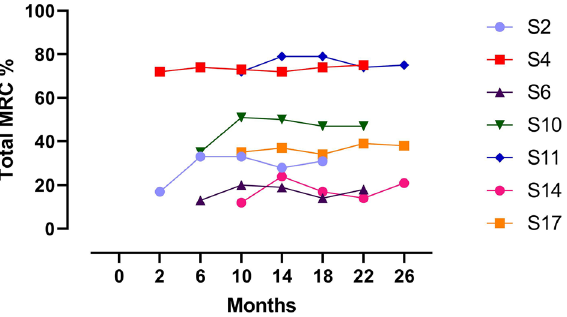
Figure 3. Individual MRC % trajectories of seven patients who were enrolled while ongoing nusinersen therapy. The first data point depicts the therapy month of enrolment; the last complies with the last assessment taken before data-cut. Individual variability of motor function in patients up to month 26 can be seen, with initial increases at the beginning of the observation period in five patients, succeeded by a predominantly stable period in three patients and a more variable trajectory in two patients. Comparing baseline to last assessment, improvement of motor function could be witnessed in most patients. Non-ambulatory patients presented with a total MRC % under 60% in the lower half of the